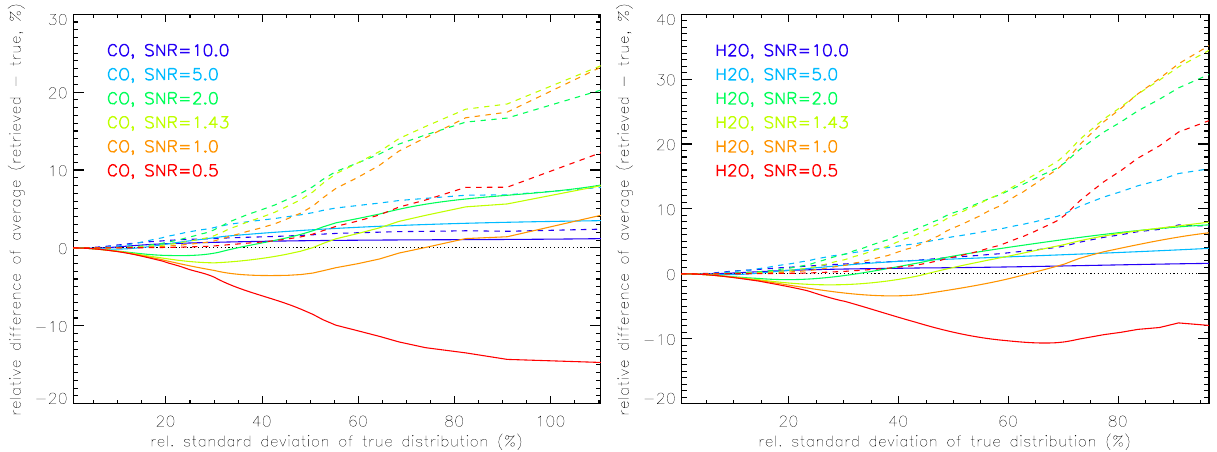
Fig. 6. Differences of retrieved and “true” zonal means (relative to the latter) versus local natural variability in terms of standard deviation for the CO (left) and H 2 O (right). Solid: linear averages, dashed: logarithmic averages. Results are shown for maximum a posteriori ln(vmr)- retrieval simulations with SNRs of 10 (dark blue), 5 (light blue), 2 (dark green), 1.43 (light green), 1.0 (orange), and 0.5 (red). Note that the a priori contribution to the retrievals is greater than 50% for standard deviations below 10%, 20%, 50%, 70%, 100%, and 200%, respectively.